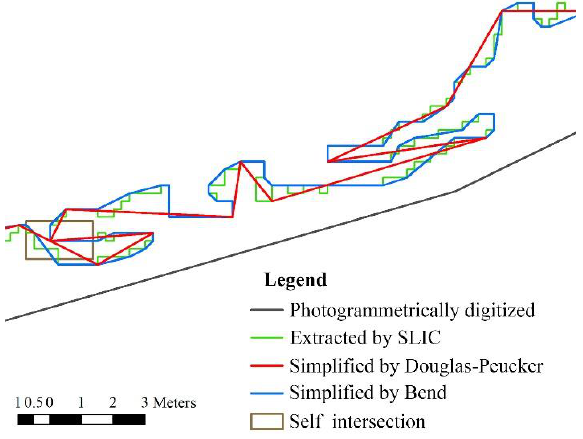
Figure 7. Evaluation of shoreline simplification with reference